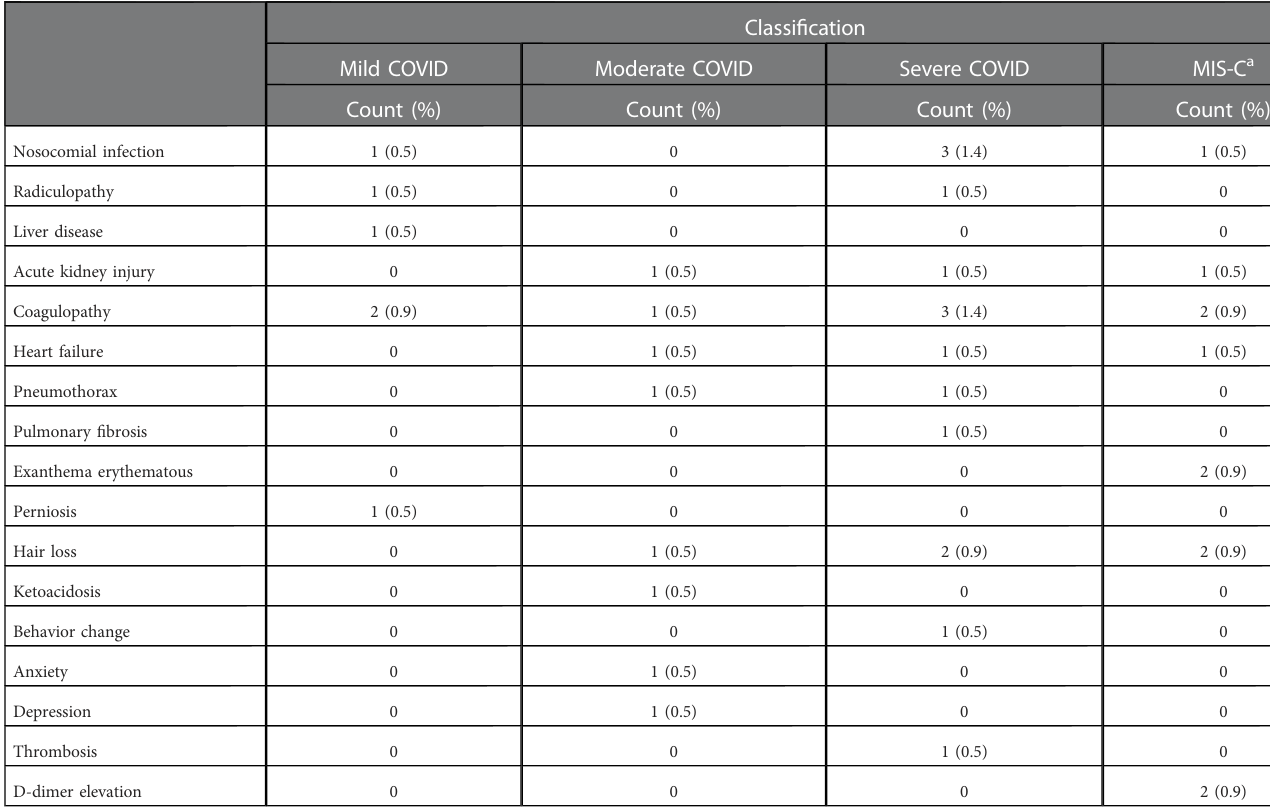
TABLE 5 Complications and sequelae associated with COVID-19